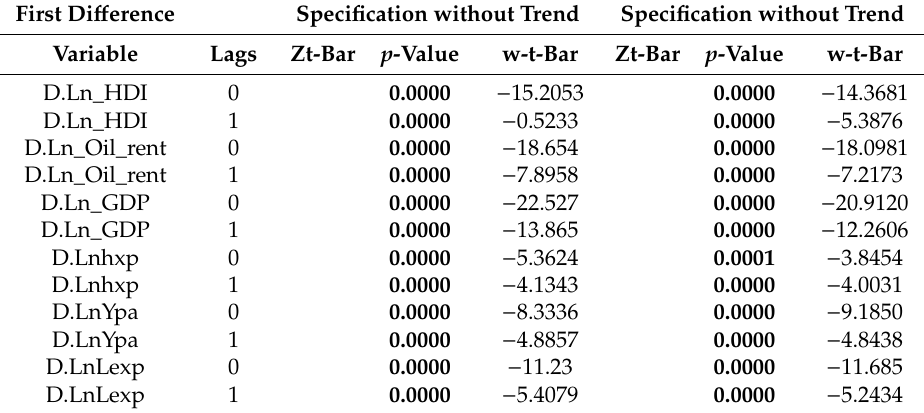
Table 11. Peaseran, (2007) Panel Unit Roots test